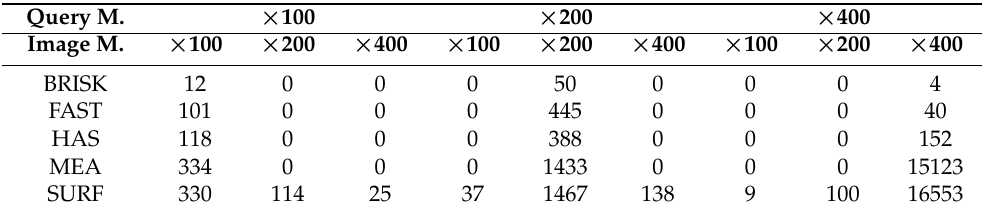
Table 5. The number of MIPs for the microscope-magnified query image (the Figure 6 case), Query M.—Query magnification, Image M.—Image magnification.